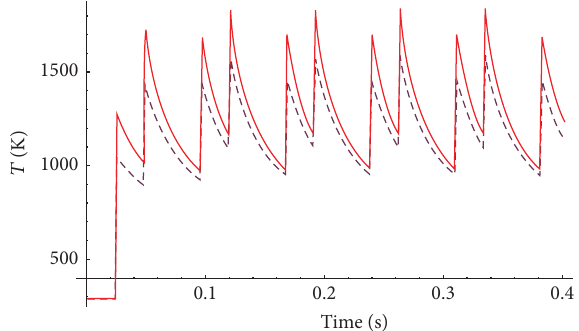
Figure 14: Evolution of maximum foil temperatures [K] at the H −